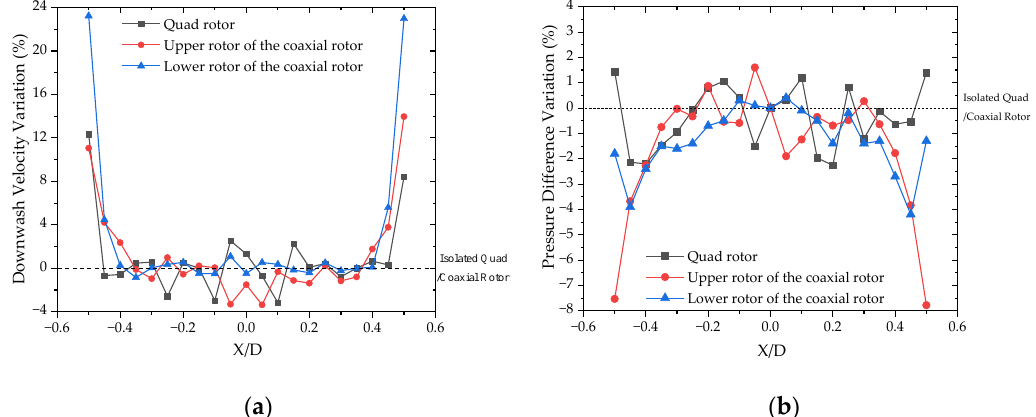
Figure 12. Velocity and pressure distribution of MAV compared with isolated quad/coaxial rotors at Re = 0.89 × 10 5 for i = 0.56. ( a ) velocity variation; and ( b ) pressure variation.